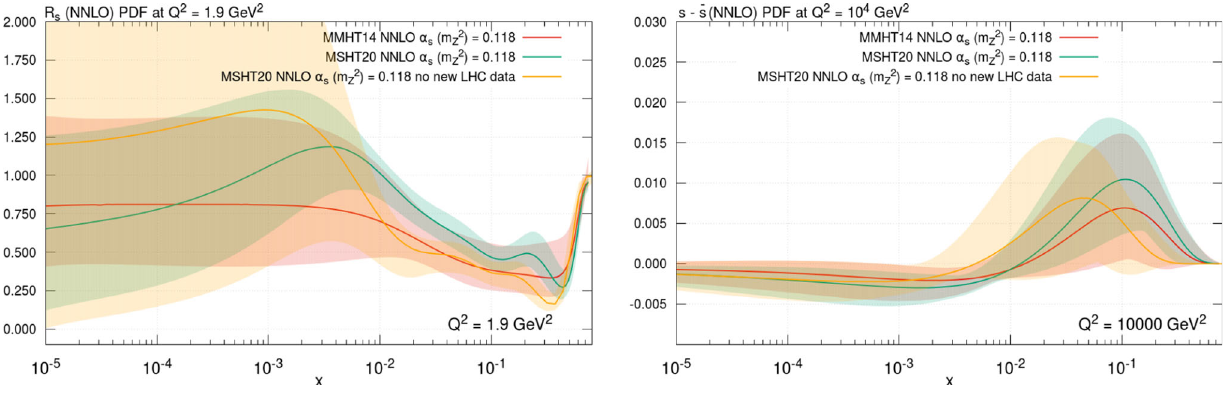
Fig. 51 (Left) R s at Q 2 = 1 . 9 GeV 2 and (right) s − ¯ s at Q 2 = 10 4 GeV 2 at NNLO comparing the PDFs upon removal of the new LHC data with the default MSHT20 fit and the MMHT14 fit